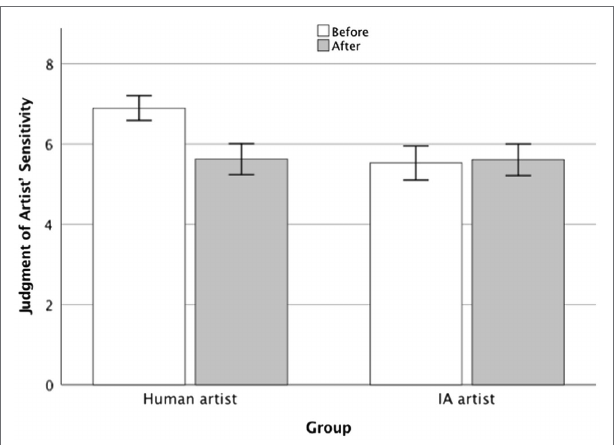
FIGURE 2 | Judgment of artist’ sensitivity before and after receiving contradictory authorship information. Error bars represent 95% CI. The figure shows the sensitivity attributed to the artist in each group at baseline, as well as the sensitivity attributed after receiving contradictory information (AI authorship in the human group and human authorship in the AI